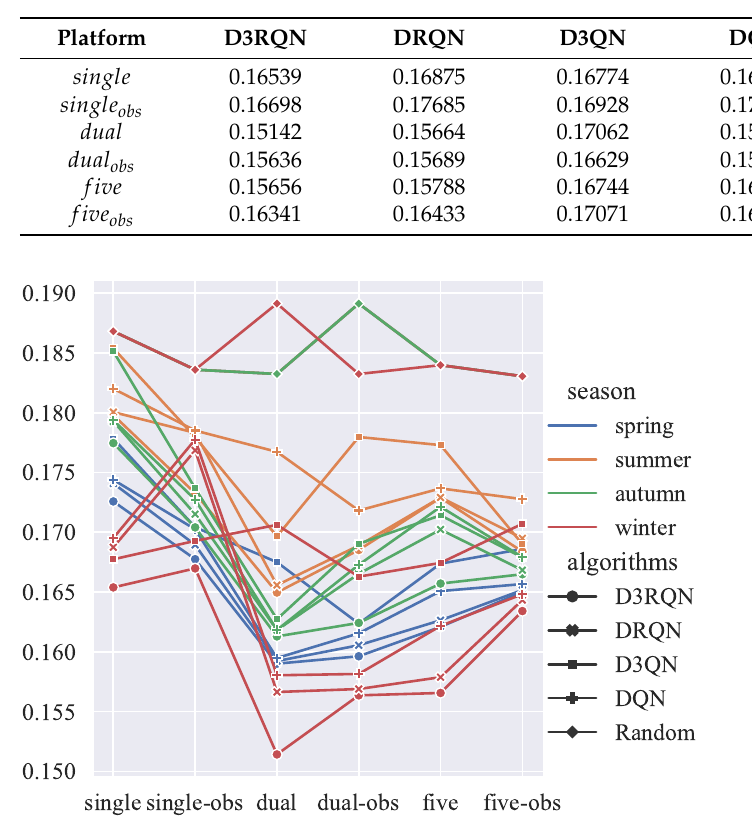
Table 6. Winter: RMSE comparison of sampling and assimilation results of the observation path between a single platform and multiple platforms, RMSE raw = 0.21733.